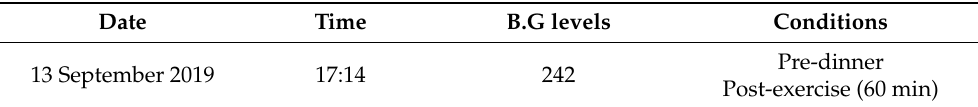
Table 2. The example of blood glucose measurement